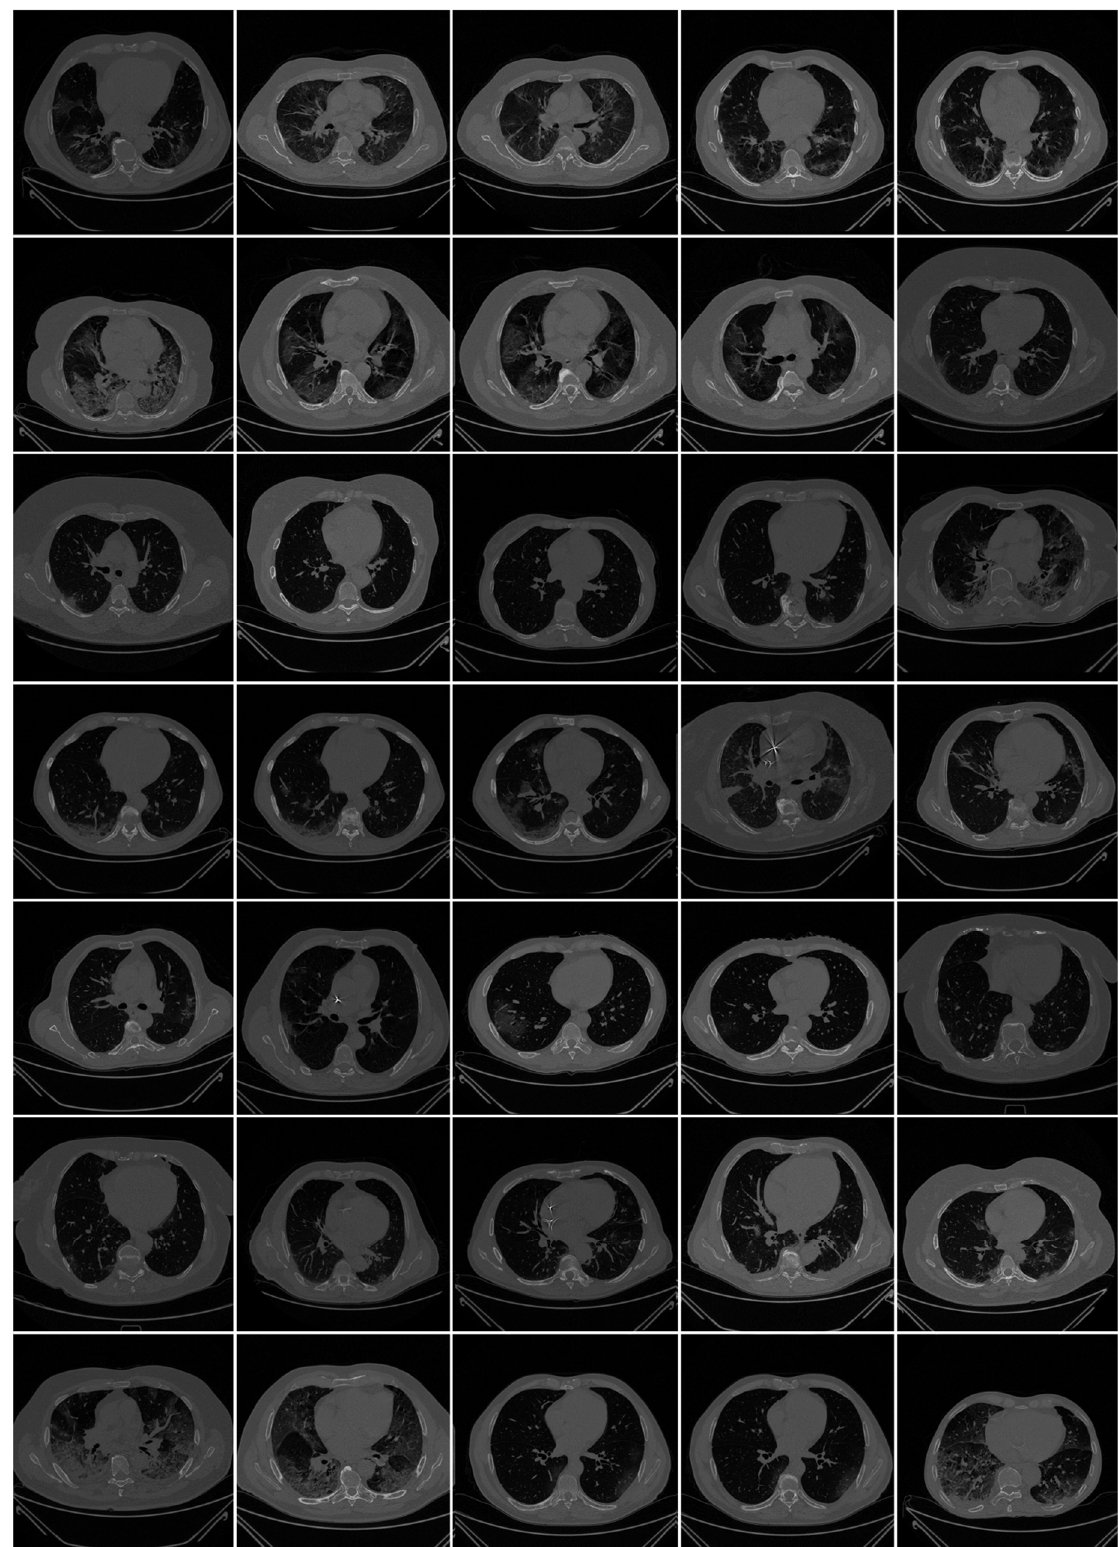
Figure 2. Raw lung COVID-19 CT scans taken from different patients in the database.